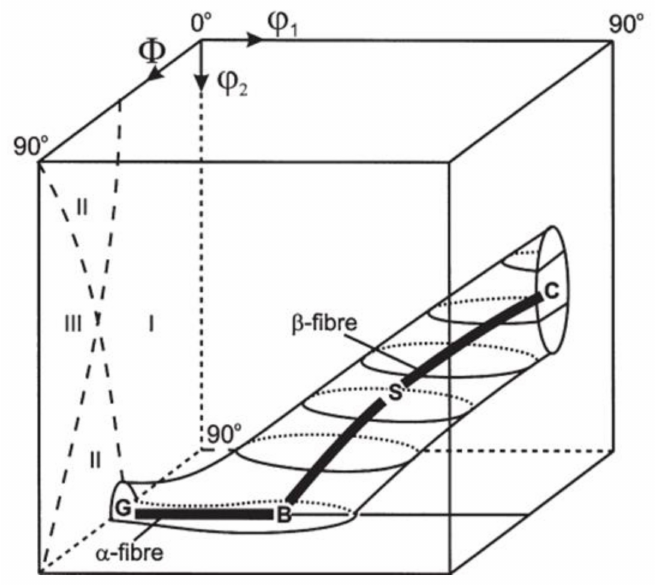
Figure 19. Ideal texture orientations on orientation distribution function (ODF).